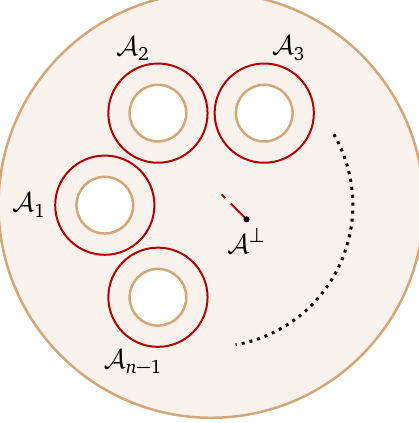
(cid:23) D . We draw S 2 ∖ n , while the n 2